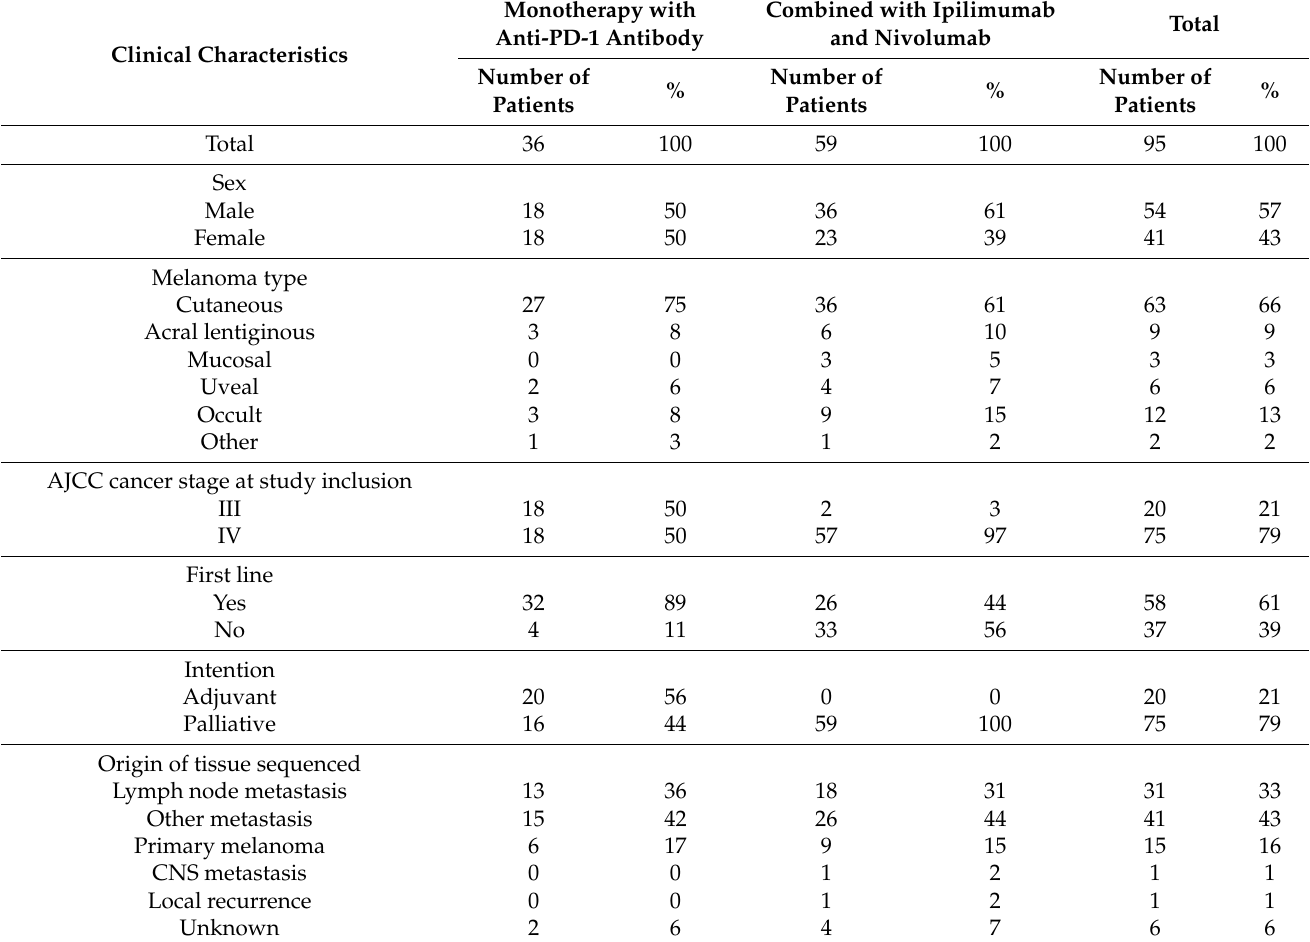
Table 1. Clinical characteristics of the cohort.